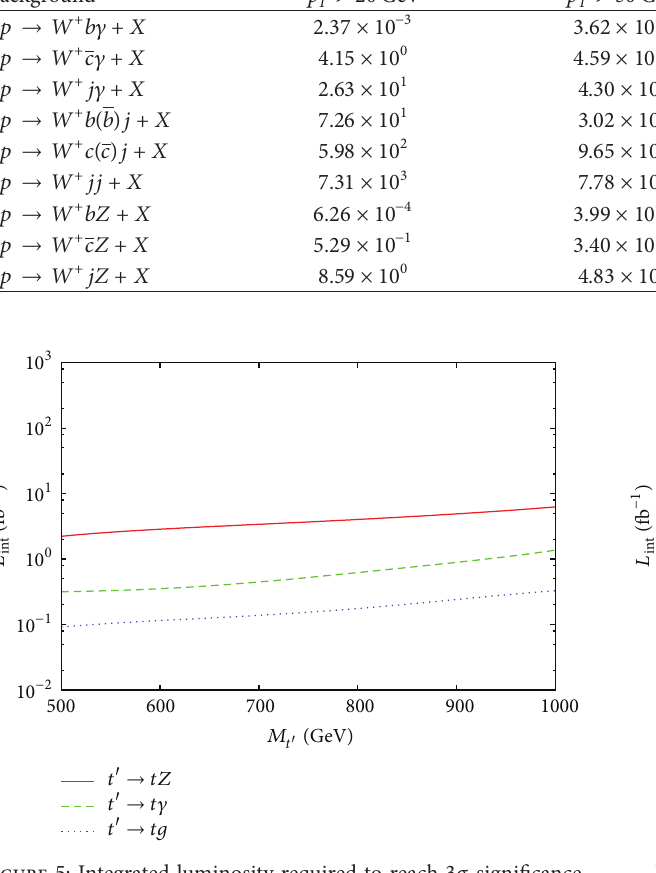
Figure 5: Integrated luminosity required to reach 3𝜎 significance for the signal of 𝑡 󸀠 anomalous interactions for parametrization PI at the LHC with √𝑠 = 13 TeV.